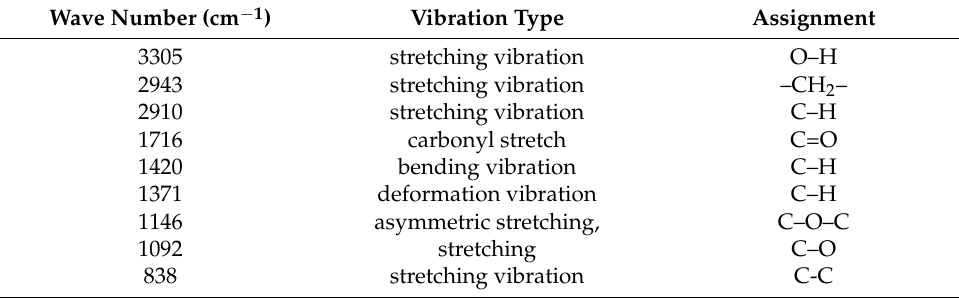
Table 2. Main FTIR peaks for the PVA nanofiber